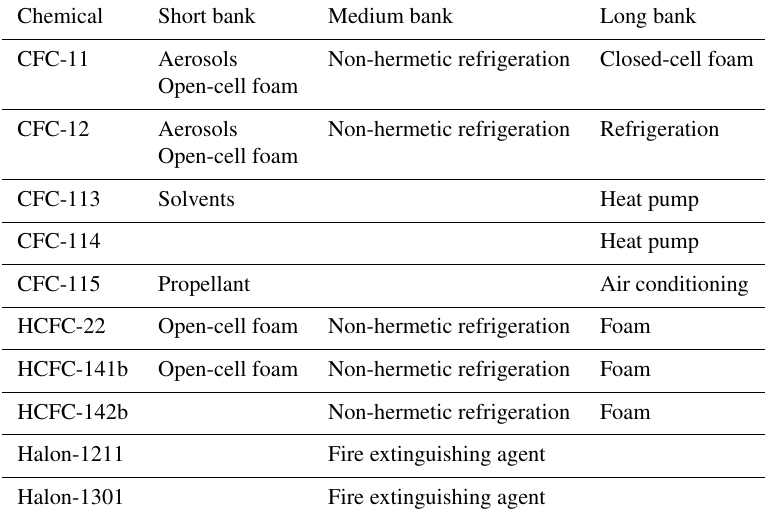
Table 1. Application type of halocarbon banks by